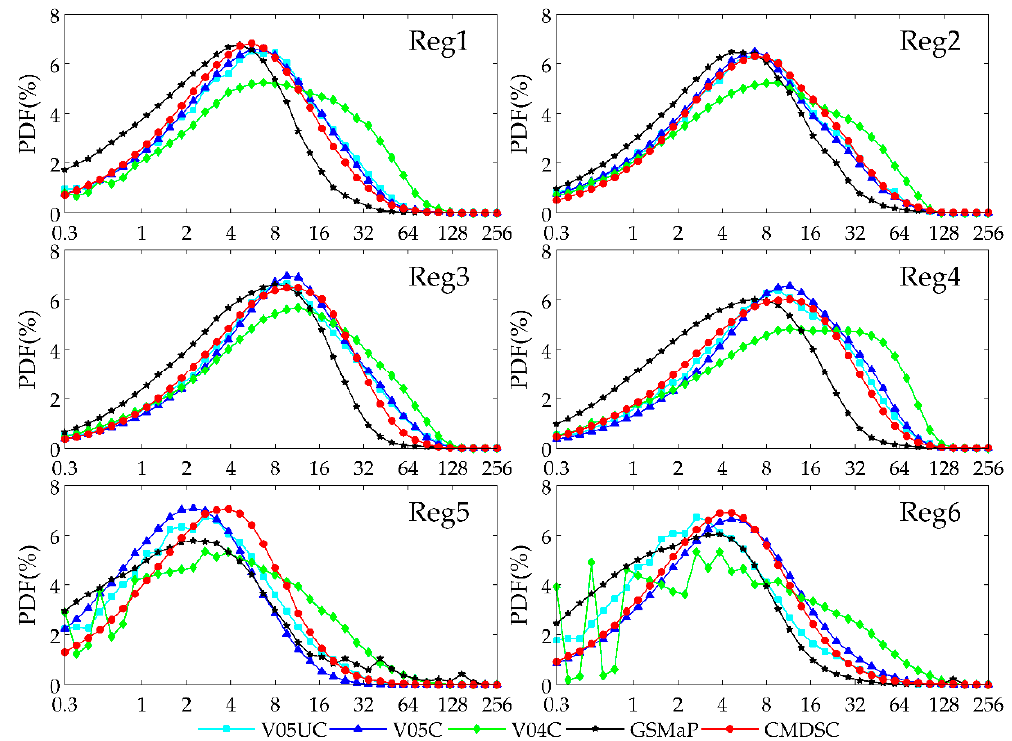
Figure 10. Probability density function of 3 h of precipitation intensity for four GSPEs (i.e., V05UC, U05C, V04C, and GSMaP) and the gauged observation in six selected regions.